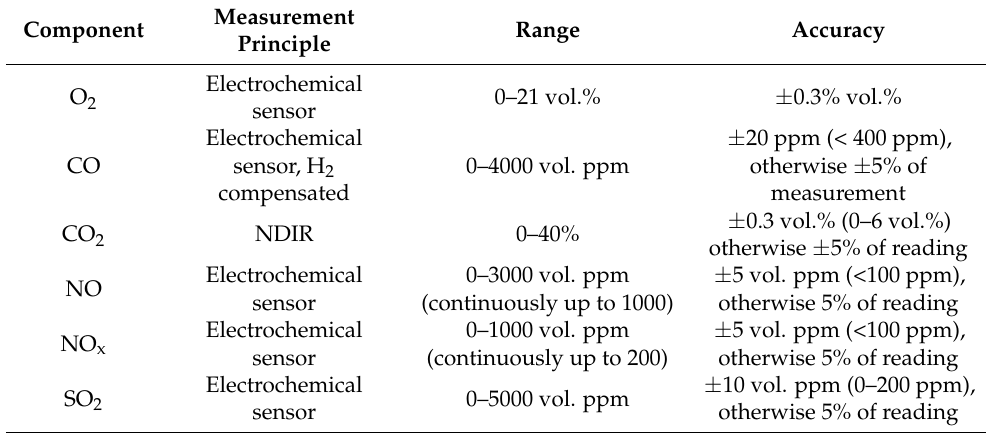
Table 5. Technical specifications of the Wöhler A 550 flue gas analyzer.